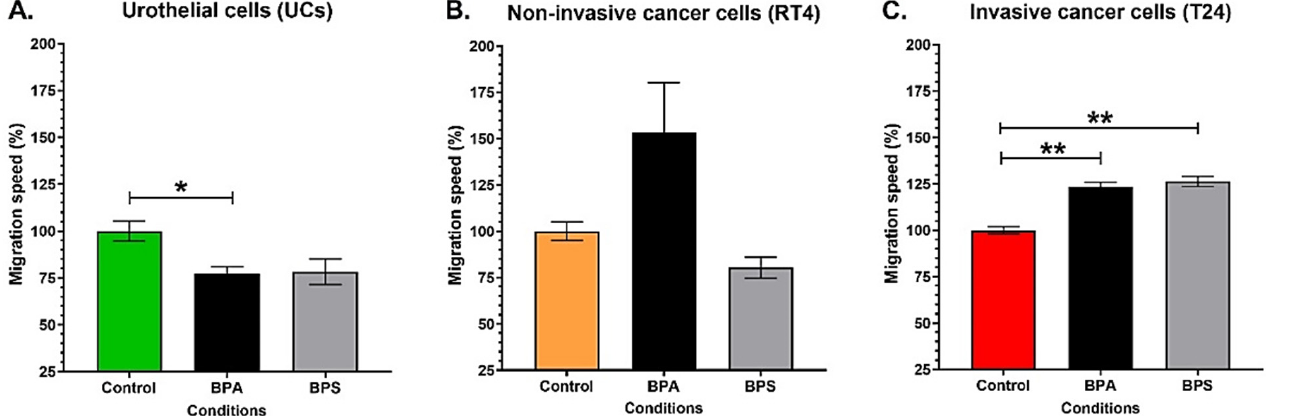
Figure 6. Chronic exposure to physiological concentrations of BPA or BPS decreases the migration speed of normal urothelial cells while increasing the migration speed of bladder cancer cells. The migration speed of ( A ) normal urothelial cells (UCs), ( B ) RT4 non-invasive bladder cancer cells and ( C ) T24 invasive bladder cancer cells was evaluated by time-lapse microscopy with or without chronic exposure to physiological concentrations of BPA or BPS. Data are presented as the mean ± SEM and displayed as percentages of controls (i.e., untreated condition) (n = 2, N = 3). The 100% migration value of UCs represents a mean of 12,06 cm 2 /h, for RT4 1,68 cm 2 /h and for T24 4,77 cm 2 /h. * p < 0.05, ** p < 0.01 by Mann–Whitney test.